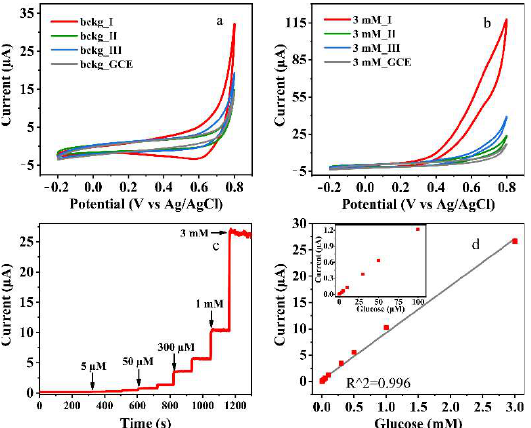
Figure 6. CV of alkaline o -phthalatocuprates in ( a ) background electrolytes and ( b ) in the presence of 3 mM of D-glucose. ( c ) Chronoamperogram of I /GCE recorded under potentiostatic conditions 0.55 V and ( d ) calibration curve for I obtained from CA data (Faraday current vs. [D-glucose]). Table 5. Electrochemical performance of the sodium o-phthalatocuprate/GC electrode and similar materials for enzyme-free glucose sensing. Electrode Material Linear Range (µM) LOD (µM) Refs.